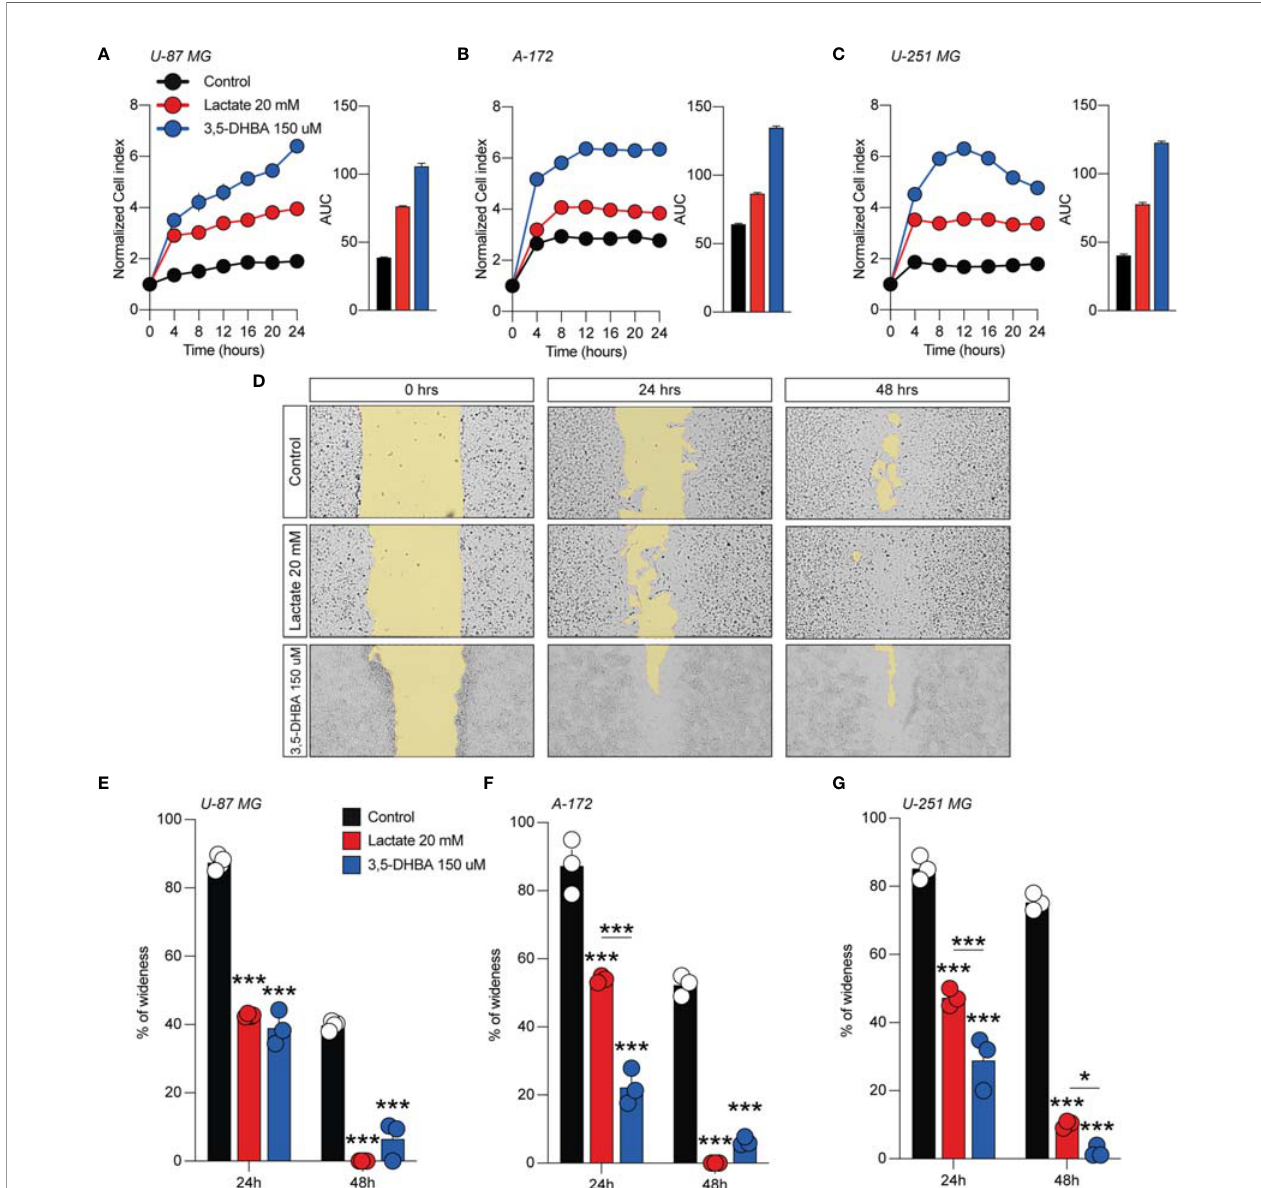
FIGURE 1 | Lactate and 3,5-dihydroxybenzoic acid (3,5-DHBA) promoted glioblastoma cell proliferation and migration. (A – C) Real-time cell proliferation monitoring in U-87 MG cells (A) , A-172 cells (B) , and U-251 cells (C) using the xCELLigence system following treatments with lactate (20 mM) and 3,5-DHBA (150 m M). The cell index values were normalized at the time of pharmacological treatments in order to obtain a normalized cell index. Each line expresses the average of four different experiments. (E – G) Analysis of human glioblastoma cell migration in U-87 MG cells (E) , A-172 cells (D – F) , and U-251 MG cells (G) with the wound healing assay following treatments with lactate (20 mM) and 3,5-DHBA (150 m M). The fi gures presented are representative of at least three independent experiments (mean ± SEM). P -values <0.05 were considered as statistically signi fi cant (* p < 0.05; *** p <